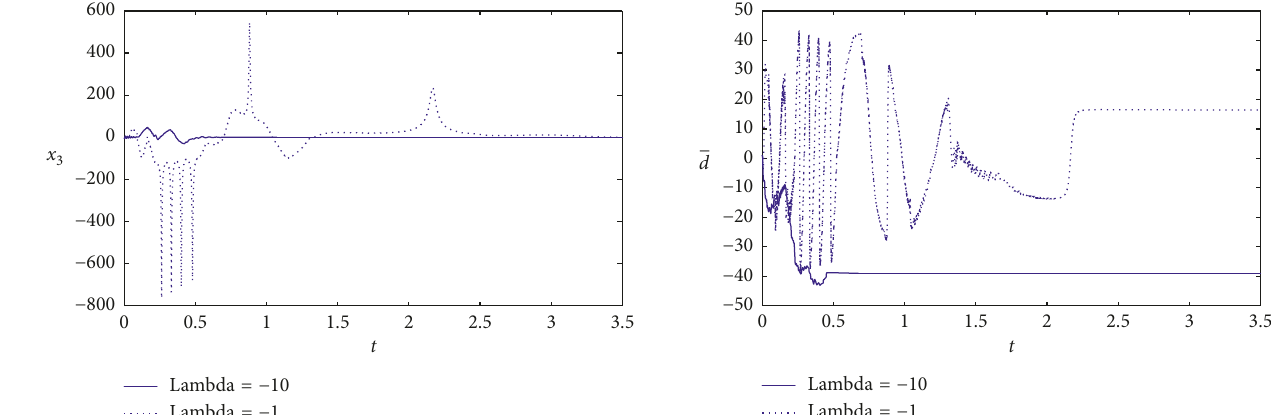
3 of system (29) with